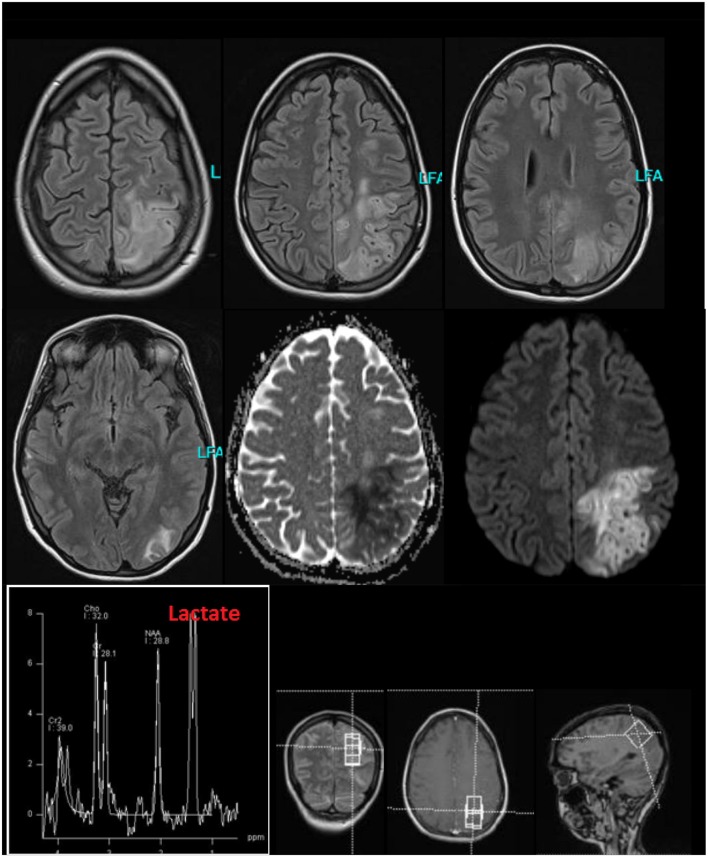
Cerebral magnetic resonance imaging (MRI) findings during the stay in the intensive care unit because of stroke like episodes. The MRI showed a subacute left parieto-occipital cortical/subcortical lesion involving the precentral gyrus with T2-weighted FLAIR signal increase and diffusion restriction without respecting vascular territories and the multiple right-hemispheric chronic posttraumatic lesions. The former subdural hemorrhage showed complete resolution. In the lesion, an increased lactate peak was registered (uncorrected data).